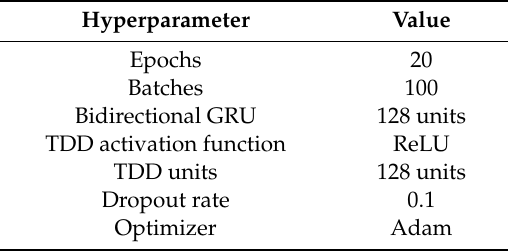
Table 4. Hyperparameter settings used in